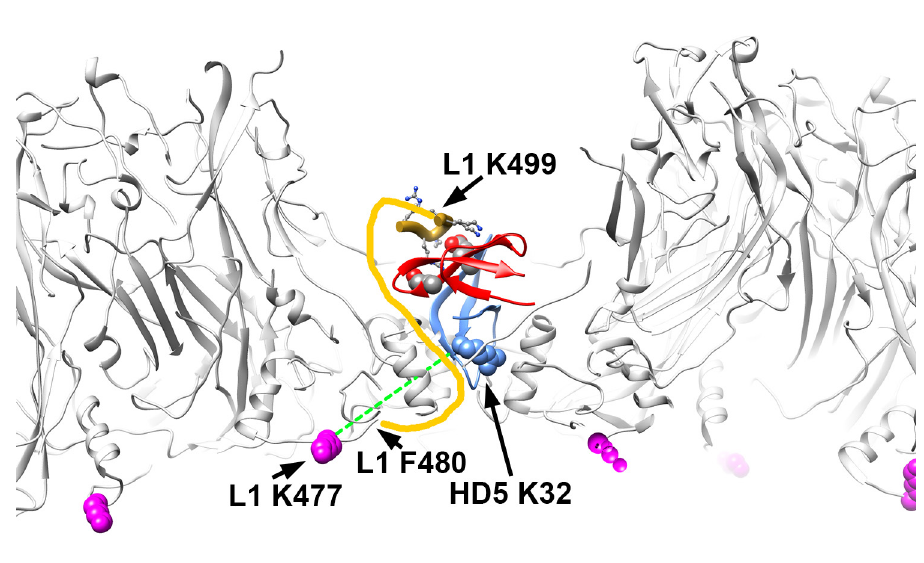
Figure 5. Structural model illustrating BS3 crosslinks between L1 and HD5 lysine residues. Side view of the L1 capsid (gray) with an HD5 dimer (red and blue) positioned within a depression between L1 pentamers such that one HD5 K32 residue (blue, space-filling) is directly above a capsid opening. The MD-derived model of an HD5 dimer and the last 6 residues of the L1 C-terminal tail (aa 499-505, gold ribbon) are shown as in Figure 4D. The flexible connecting residues between L1 F480 (Chain F) on the inner capsid surface and L1 K499 near the HD5 interaction site are depicted as a yellow line. The distance that would have to be spanned to connect these 2 residues (F480 and K499) is 3.7 nm, which is consider- ably less than the extended length of a 19 aa peptide (6.9 nm). Residue L1 K477 (magenta, space-filling) is detected as crosslinked to HD5 and is on the inner capsid surface. The dashed green line represents a distance of 2.8 nm and serves to indicate that the maximum distance constraint (3 nm) between Cα atoms of BS3 crosslinked lysines is met by this structural